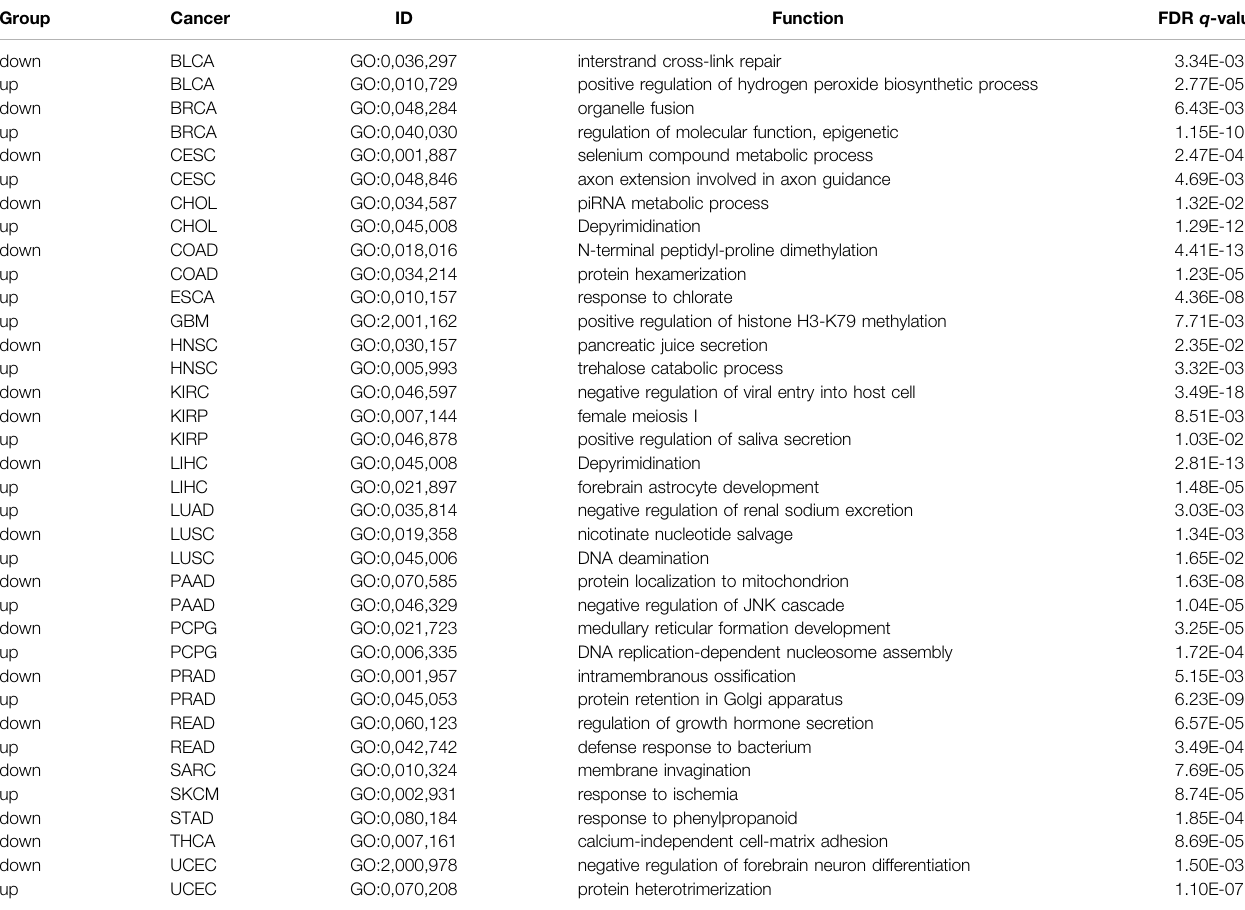
TABLE 3 | The functions of speci fi c lncRNAs for each cancer.